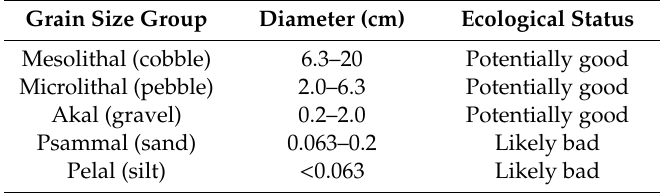
Table 2. Assessment classes according to the median diameter d 50 of bed sediment (modified after Reference [32]).